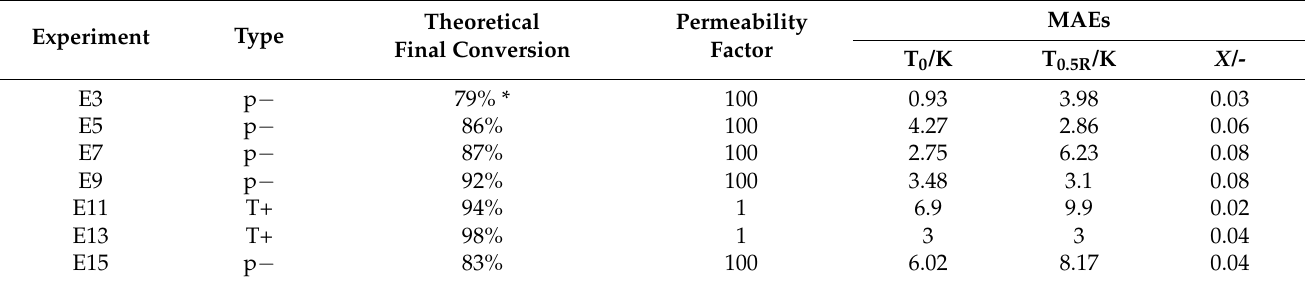
Table 4. Overview of the mean absolute errors between experiments and